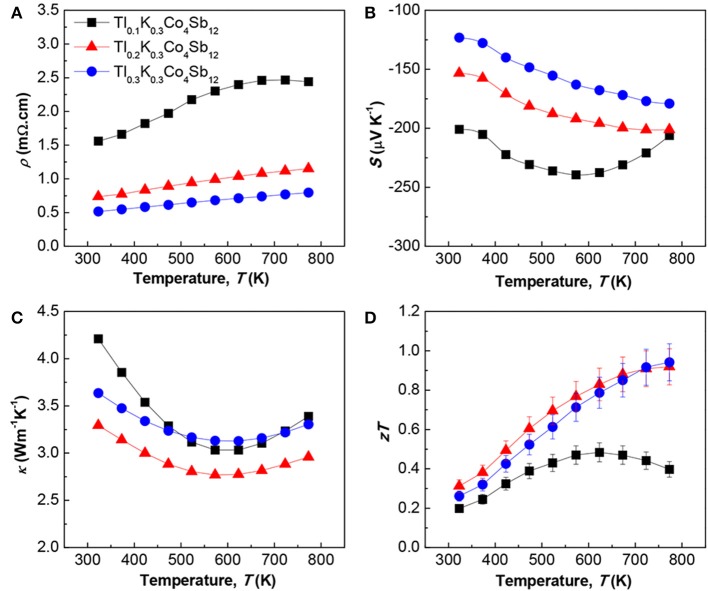
Temperature dependences of (A) electrical resistivity ρ, (B) Seebeck coefficient S, (C) thermal conductivity κ, and (D) dimensionless figure of merit zT of polycrystalline bulk samples of TlxK0.3Co4Sb12 (x = 0.1 − 0.3).